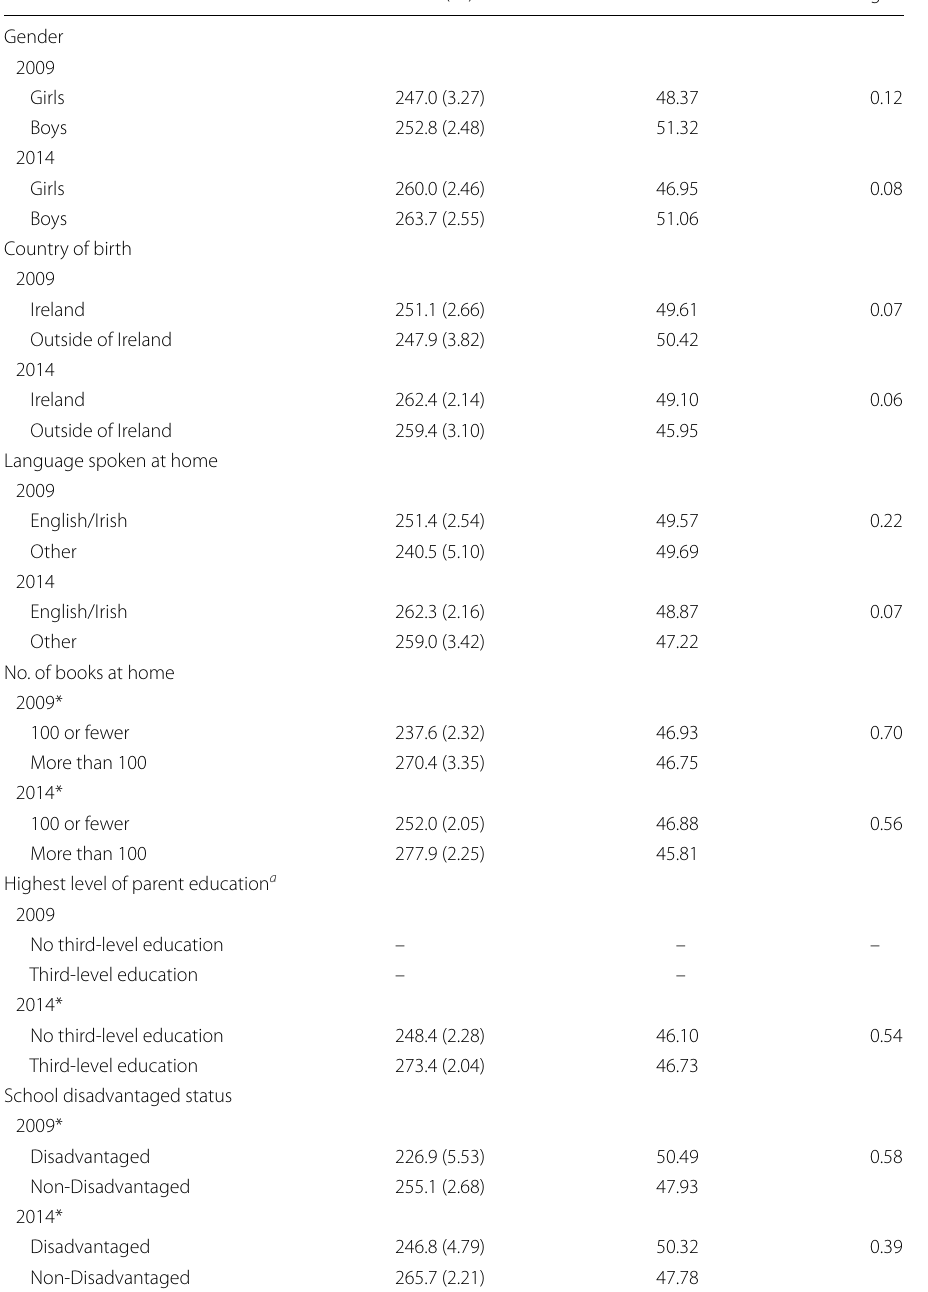
Table 4 Differences in mathematics performance between NAMER 2009 and 2014 for selected groups of